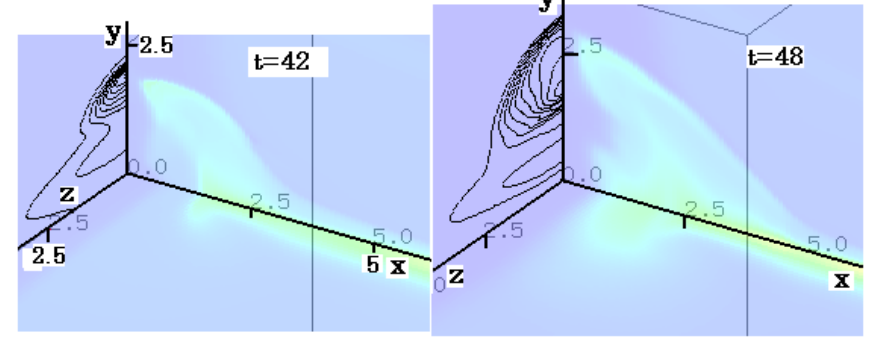
Fig. 10. Temperature distributions in the corona and in the chromosphere ( x = 0) by contour lines at different times.